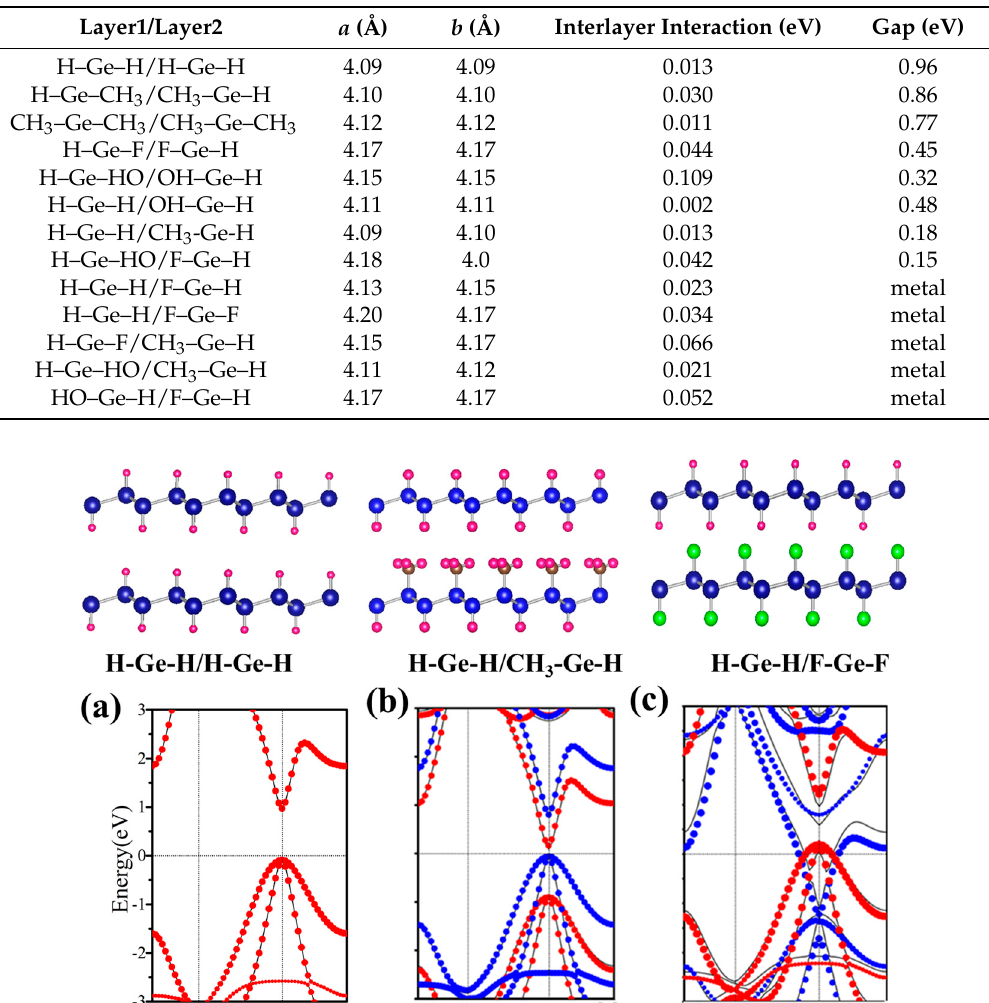
Table 2. Structural parameters (Å), interlayer interaction energies (eV/Ge atom) and band gaps (eV) determined for bilayer germanene functionalized with several radicals, at full coverage.